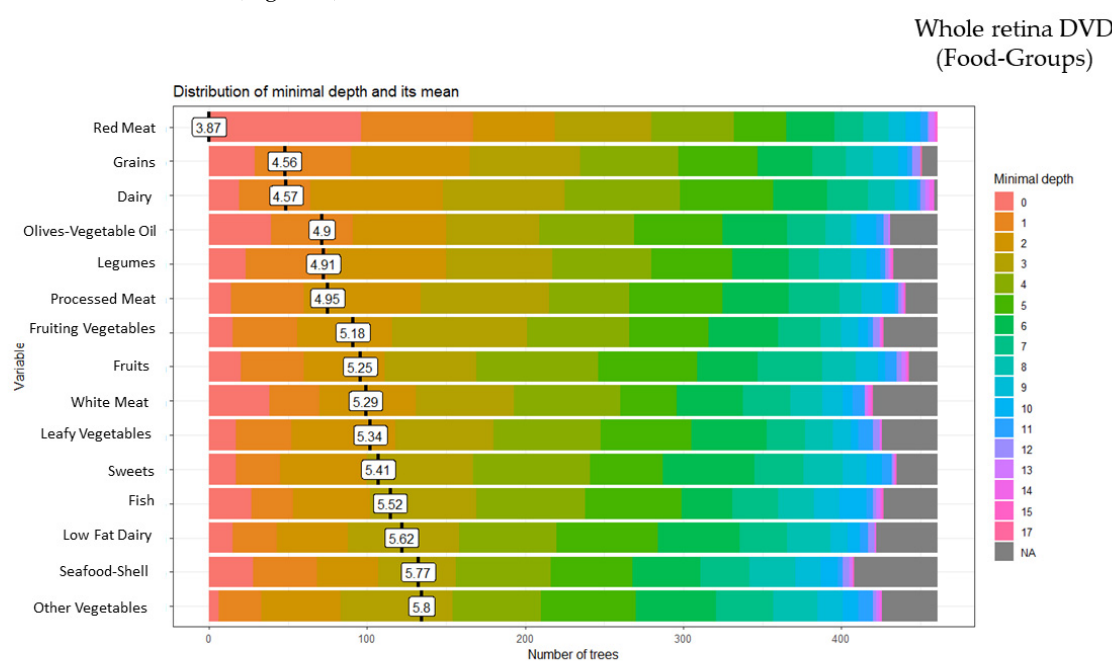
Figure 4. Random forest food group and whole retina deep vessel density (DVD).